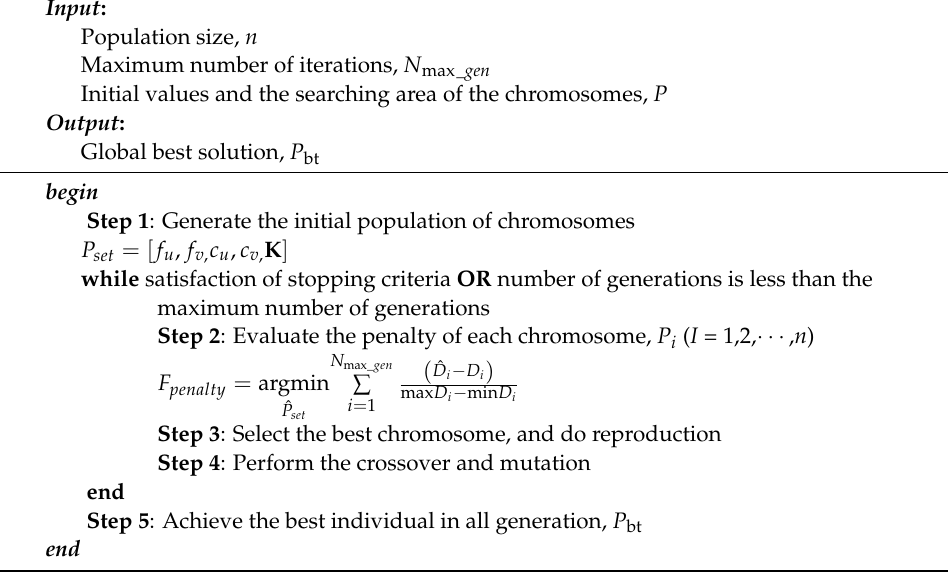
Algorithm 1. Procedure of optimizing intrinsic parameters of the vision sensor with genetic algorithm.